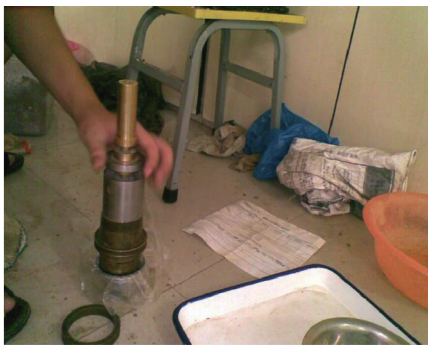
Figure 2: DDS-70 dynamic triaxial testing system.